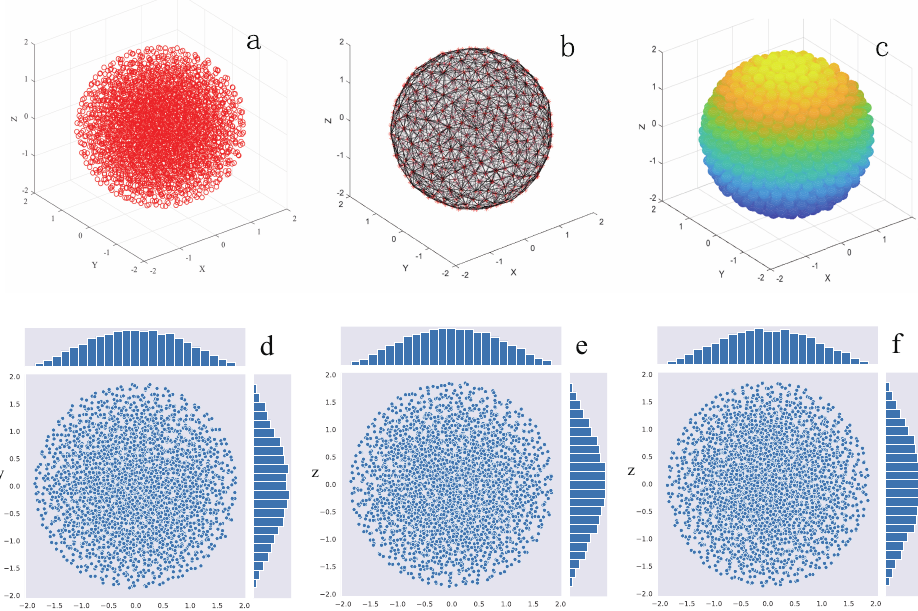
Figure 2. ( a ) 3D nodes diagram. ( b ) 3D topology. ( c ) 3D balls diagram. ( d ) The projection of the XoY plane. ( e ) The projection of the XoZ plane. ( f ) The projection of the YoZ plane.